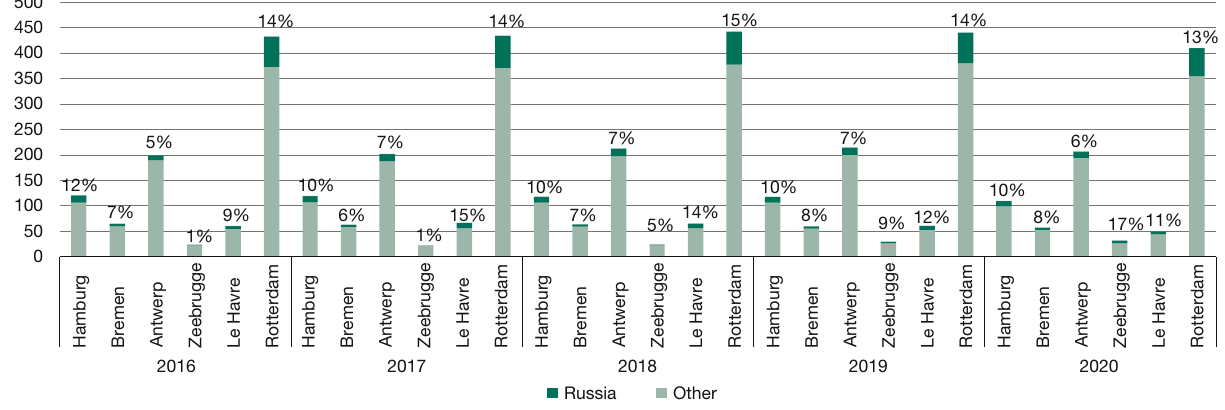
Source: Eurostat